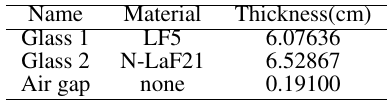
Table 1. NSPWII system compensation glass design scheme